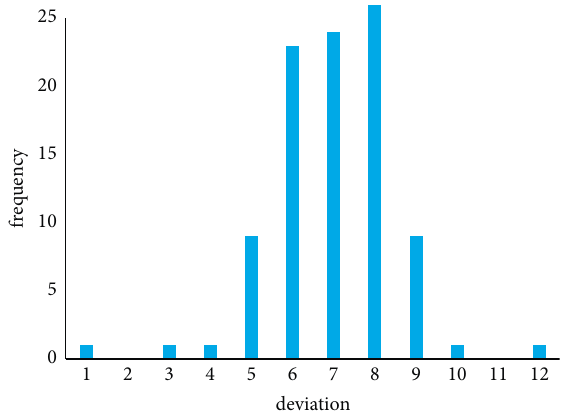
Figure 5: Statistical frequency distribution results of power deviation.